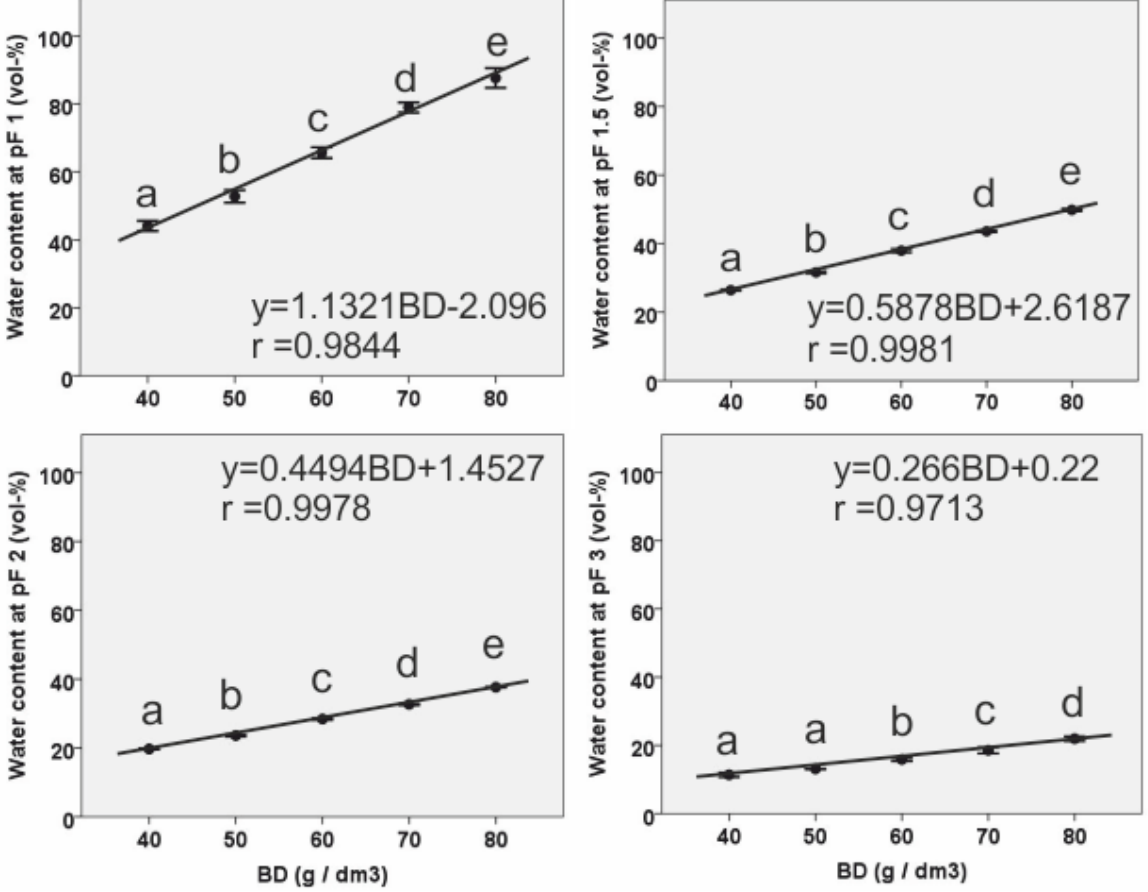
Figure 8. Volumetric water content of Sphagnum samples ( BD 40 to 80 g dm -3 ) at pF 1, 1.5, 2 and 3. Means ± standard deviation (SD) are presented (n = 3). Significant (p < 0.05) differences in water content between different bulk densities are indicated by different letters above the data points. Table 1. Variation in hydraulic conductivity ( K ) and in double van Genuchten (DvG) WRC s